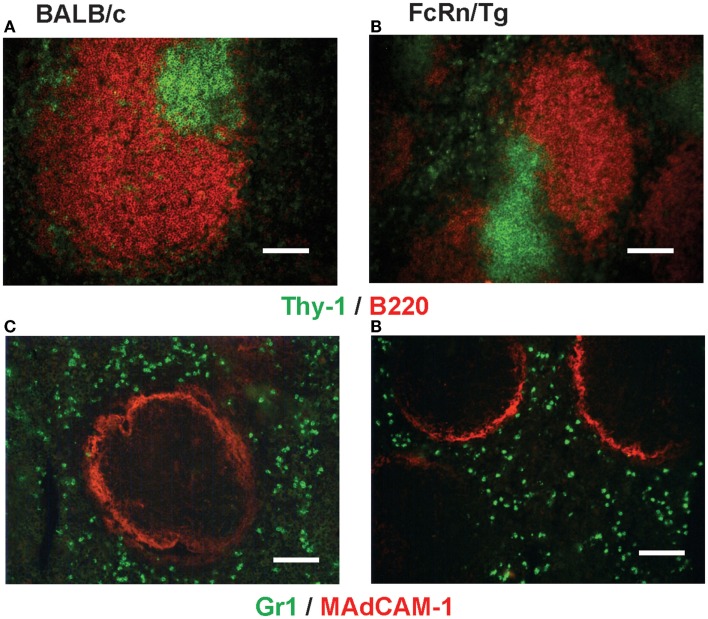
Histological analysis of the spleen of bFcRn Tg mice. White pulp in spleens in wt (A,C) and Tg mice (B,D) contains clearly defined T cells (Thy-1/CD90, green) and B cells (B220, red) forming separate compartments. The white pulp is encircled with MAdCAM-1 positive (red) marginal sinus, separating the white pulp from the red pulp containing Gr1-positive (green) myeloid cells (representative examples for a cohort n > 6; scale bar: 100 μm).